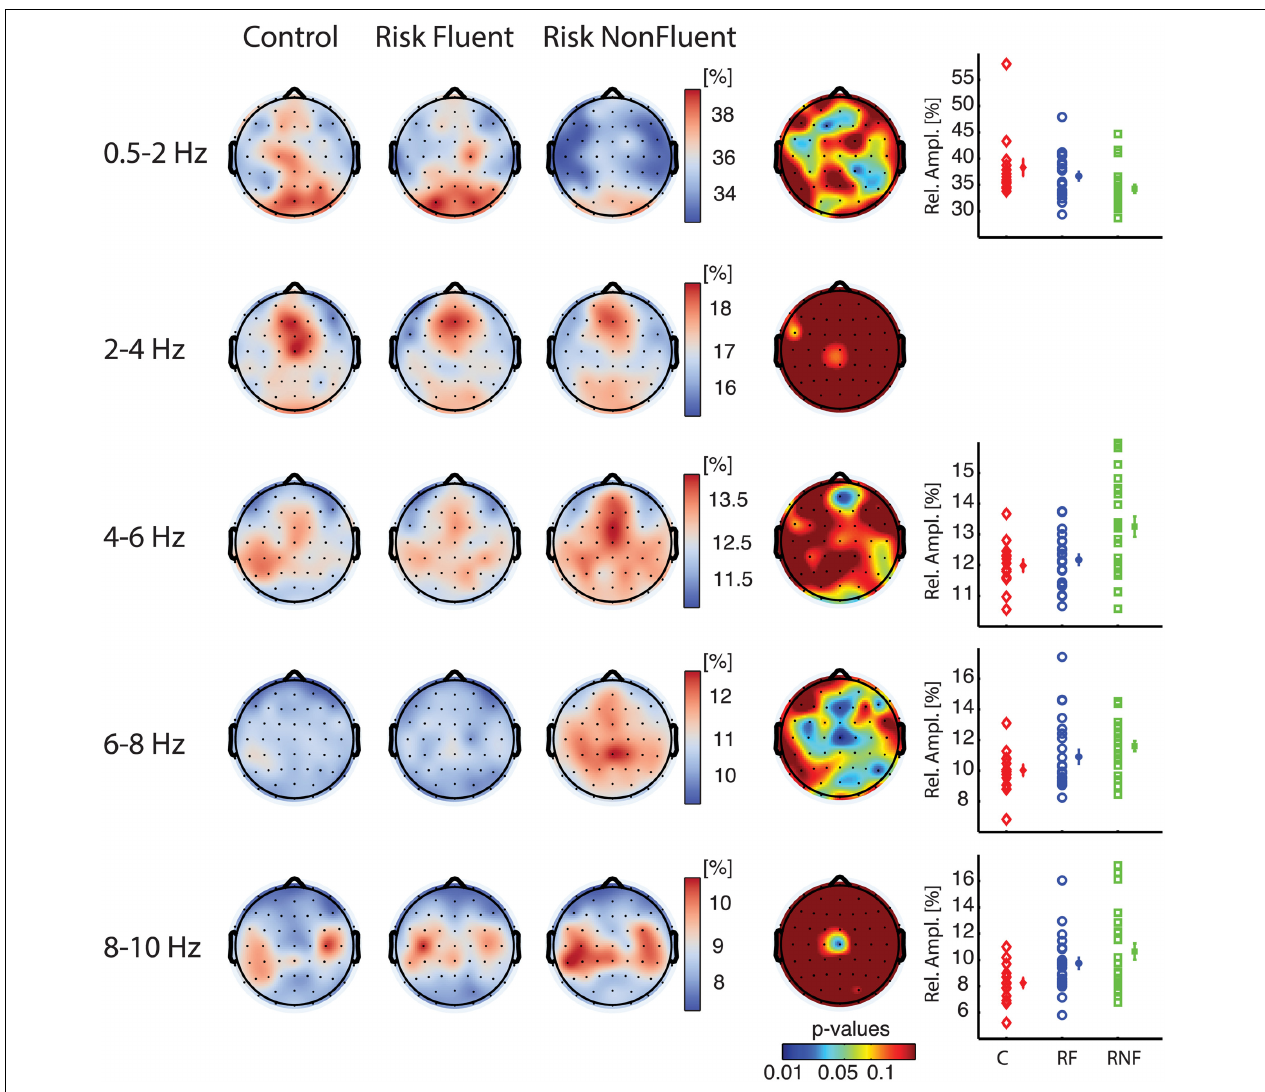
FIGURE 2 | Relative amplitude spectra in delta-1 (0.5–2Hz) and alpha-1 (6–8Hz) bands discriminate children becoming fluent from children becoming non-fluent readers. Grand-median topographies of delta-1, delta-2, theta, alpha-1, alpha-2 relative amplitude are shown for control ( first column ), at-risk fluent readers ( second column ), at-risk non-fluent readers